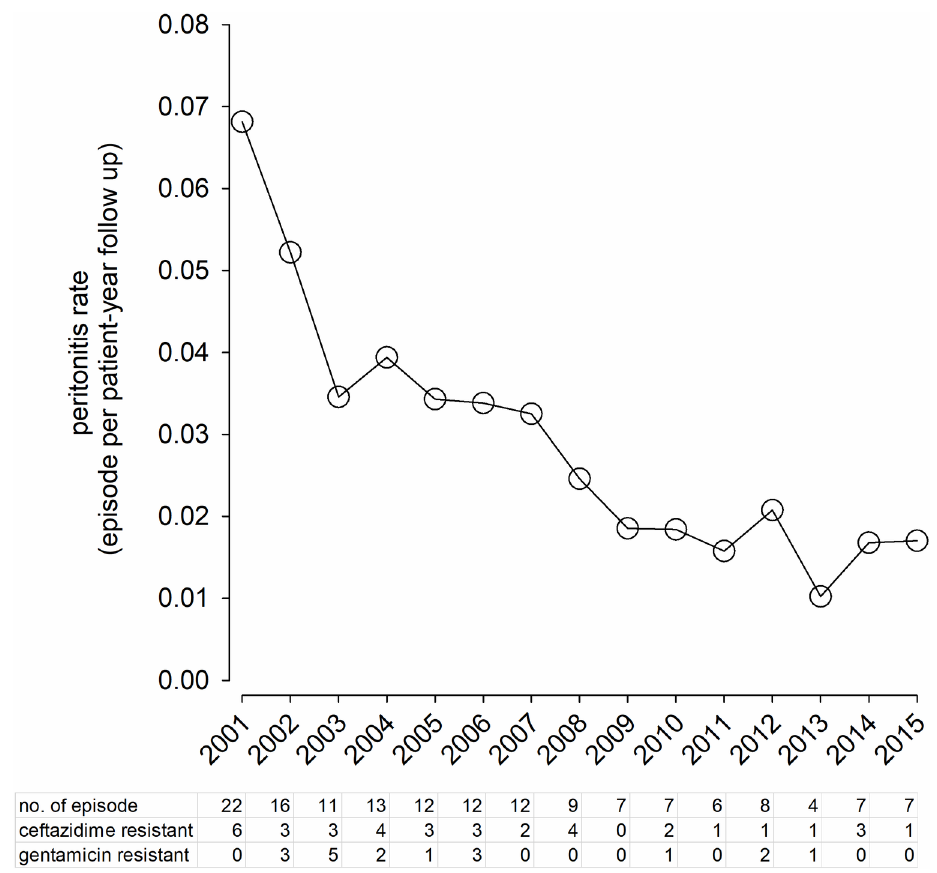
Fig 1. Change in incidence and evolution of antibiotic resistance of Pseudomonas peritonitis from 2001 to